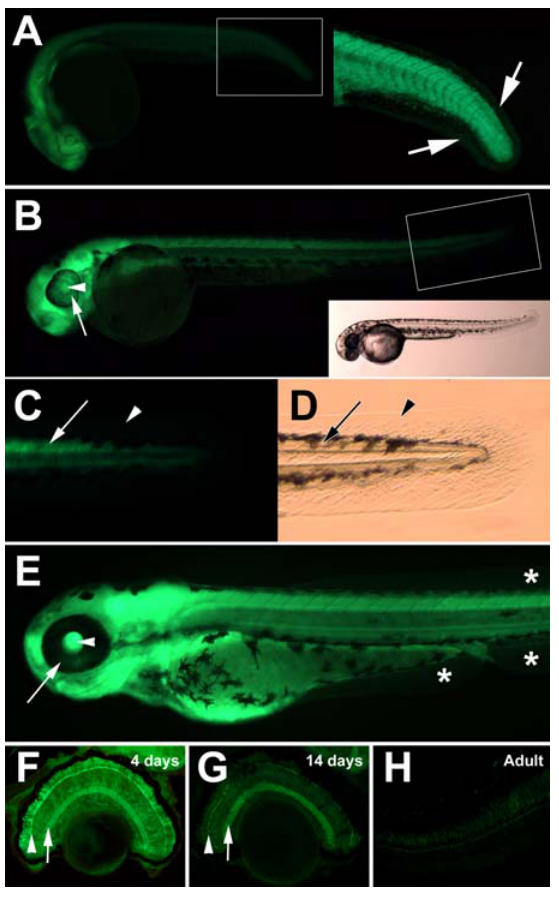
FIGURE 3. Expression of Tg( H2A.F/Z:EGFP ) nt during zebrafish development. (A) A Tg( H2A.F/Z:EGFP ) nt embryo showing uniform EGFP expression (left panel). The boxed region is magnified to the right and reveals the weak EGFP expression in the developing fin fold (right panel). (B) At 48 hpf, EGFP expression persists in the retinal neuroepithelium (arrow), and the developing lens (arrowhead). The boxed developing tail bud region is magnified in panels C and D. (C) Left panel, EGFP expression is observed in the developing tail bud (arrow), but not in the developing caudal fin fold (arrowhead). Right panel, brightfield image of left panel. (D) A transgenic embryo at 4 dpf shows persistent EGFP expression in the body and lens (arrowhead), reduced expression in the retina (arrow), and continued absence of expression in the fin folds (asterisks). (E) A frontal section from a 4-dpf embryo shows low-level ubiquitous expression of the H2A.F/Z:EGFP transgene in the retina. Elevated EGFP expression is present in the outer plexiform layer (OPL, arrowhead) and inner plexiform layer (INL, arrow). Expression in the lens is low, indicating that the lens expression observed in wholemount embryos (panel C, right) includes some refraction of the retinal expression. (F) A frontal retinal section at 14 dpf shows H2A.F/Z:EGFP transgene expression in the retina near background levels, except for the OPL and IPL (arrowhead and arrow, respectively). (G) Section from an adult Tg( H2A.F/Z:EGFP ) nt shows an absence of transgene expression in the retina.